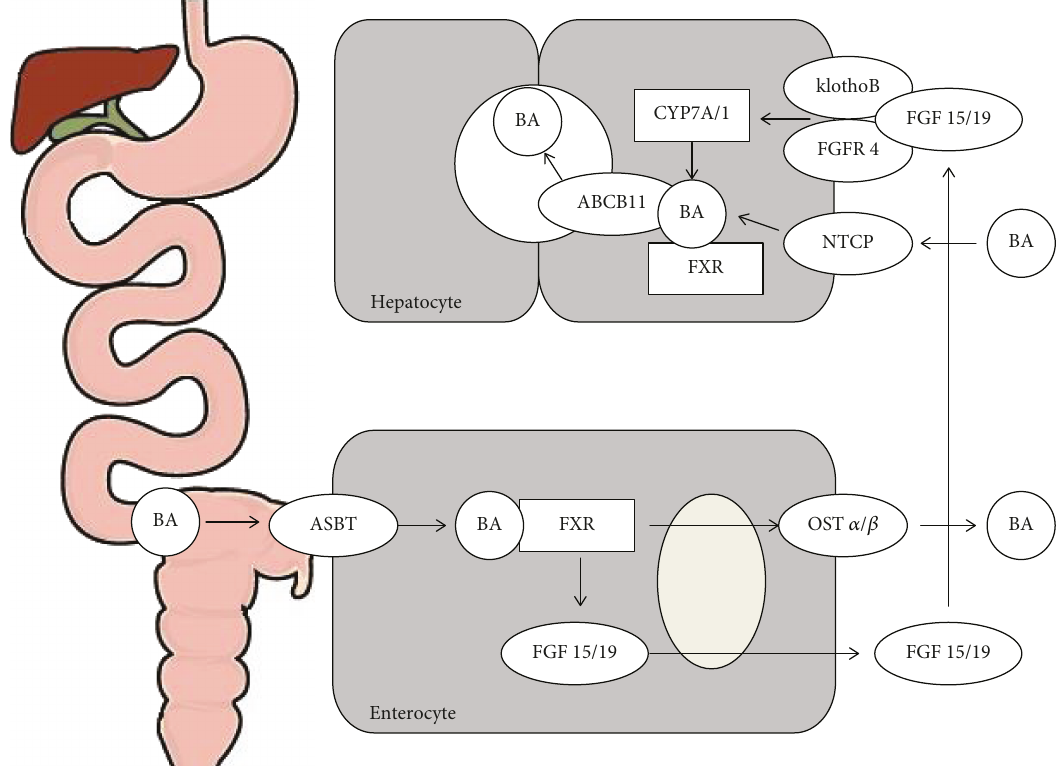
Figure 2: Pathophysiology of enterohepatic circulation: bile acids (BAs) excreted in the intestinal lumen are mainly reabsorbed in the ileum through the apical sodium-dependent bile acid transporter (ASBT) and return to the liver through the portal vessels. Stimulation of the farnesoid X receptor (FXR) initiates the production of fi broblastic growth factor 15/19 (FGF-15/19) that interacts in the hepatocytes with cholesterol 7 alpha-hydroxylase (CYP7A/1) and reduces BA synthesis, with a negative feedback mechanism. Mutations in ASBT and klothoB have been demonstrated to be a cause of bile acid malabsorption